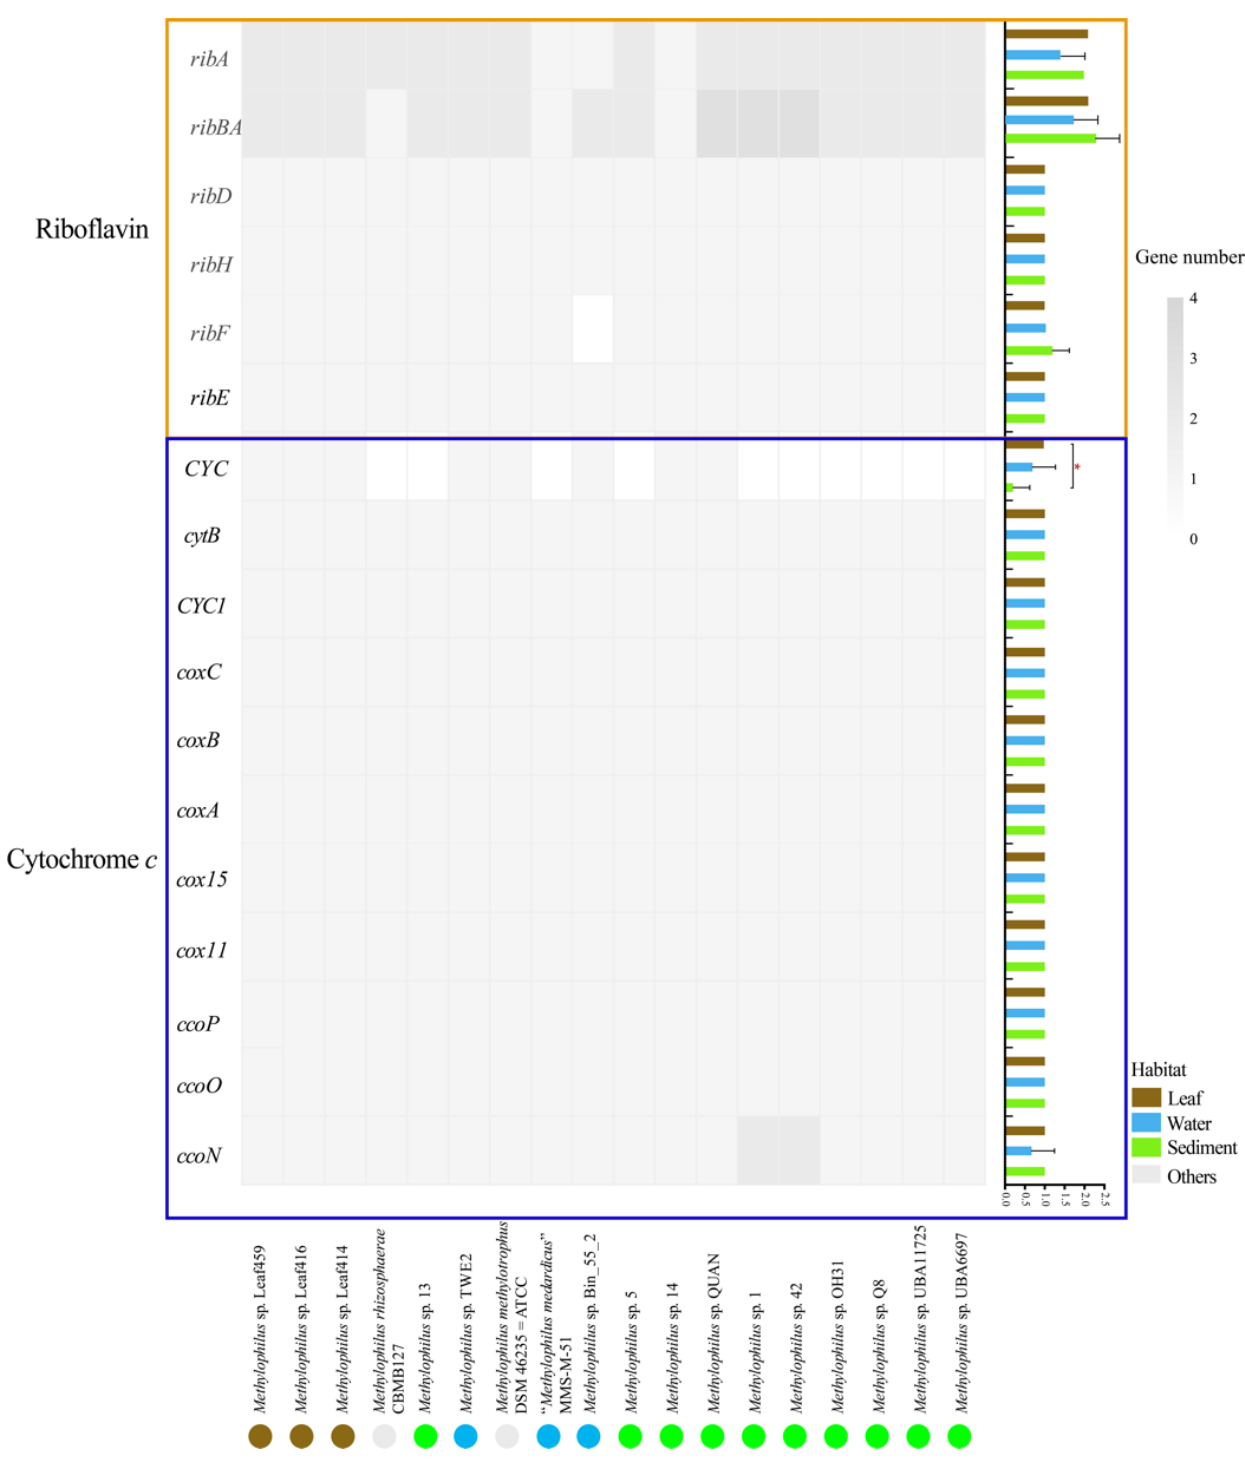
Figure 8. Distribution of genes encoding cytochrome c and riboflavin in Methylophilus genomes. The colored boxes indicate that the gene is present in the genome, whereas the white box indicates that it is absent. The solid circles with colors, blue, brown, green and grey, represent isolation sources, water, leaf, sediment and others, respectively. The histogram was constructed by computing the normalized number of all genes encoding cytochrome c and riboflavin. Three box colors represented three environments. The boxplots were constructed by computing all gene numbers. Three box colors represented three environments. Significant differences in CYC gene between leaf versus sediment environment by one-way ANOVA. *: p < 0.05.